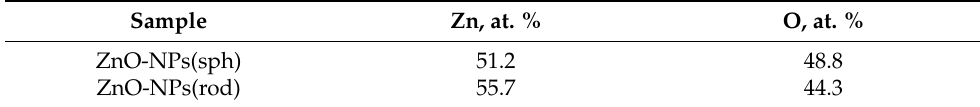
Table 2. The EDS analysis data for the spherical and rod-shaped ZnO-NPs. Sample